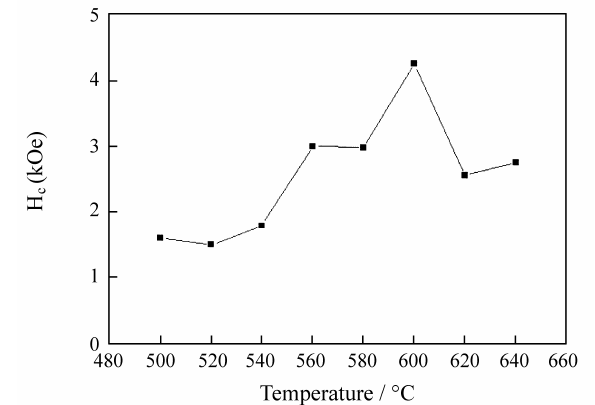
Figure 6. Irreversible susceptibility χ irr vs. applied field H for samples WC and PC, flash-annealed at 600 and 520 °C respectively for 30 s.